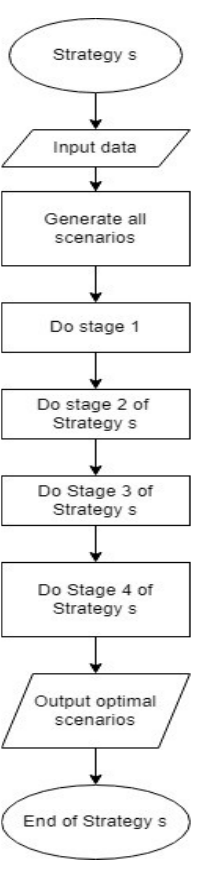
Figure 7. General flowchart for all strategies. S can be Strategy 1, 2a, or 2b.